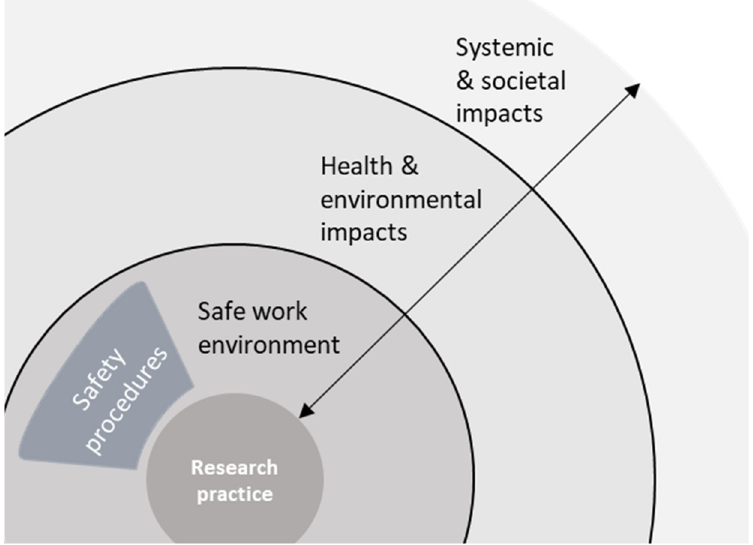
Figure 4. Attention for work safety is covered by adherence to safety procedures (the arrow depicts types of safety issues and distance from research